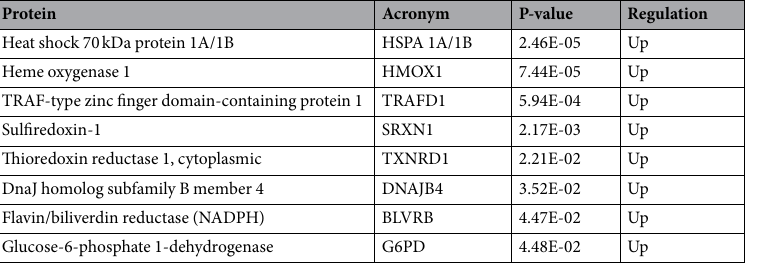
Table 2. Proteins significantly regulated following RAPTA-EA treatment determined from FITExP analysis of MCF-7 and MDA-MB-231